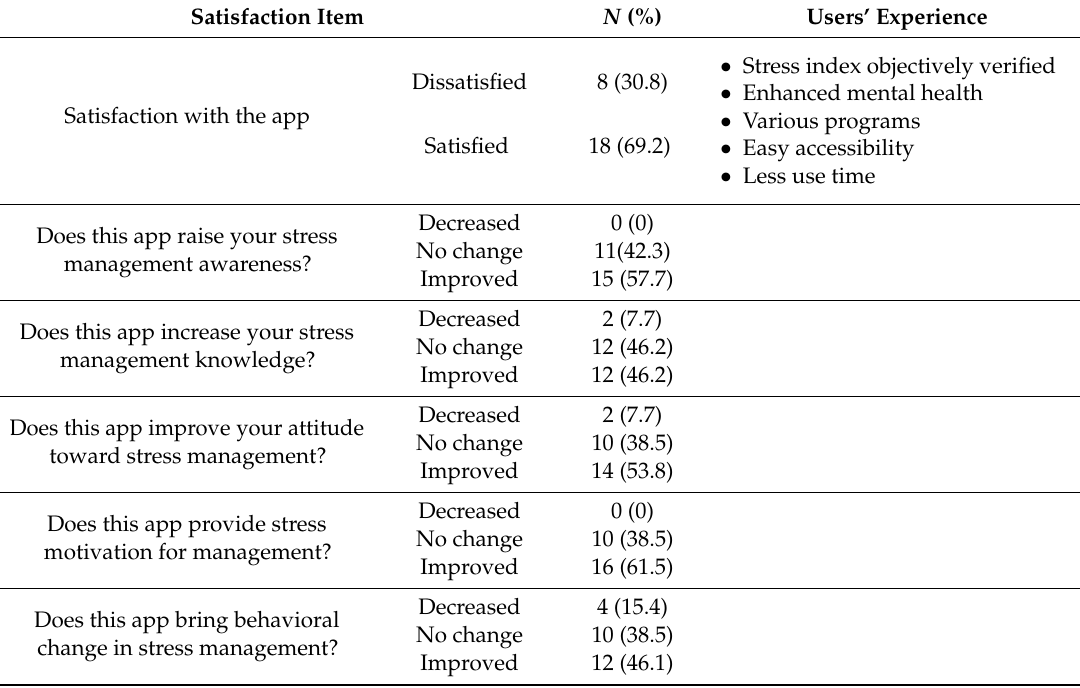
Table 4. The users’ satisfaction and experience with the app ( N = 26).